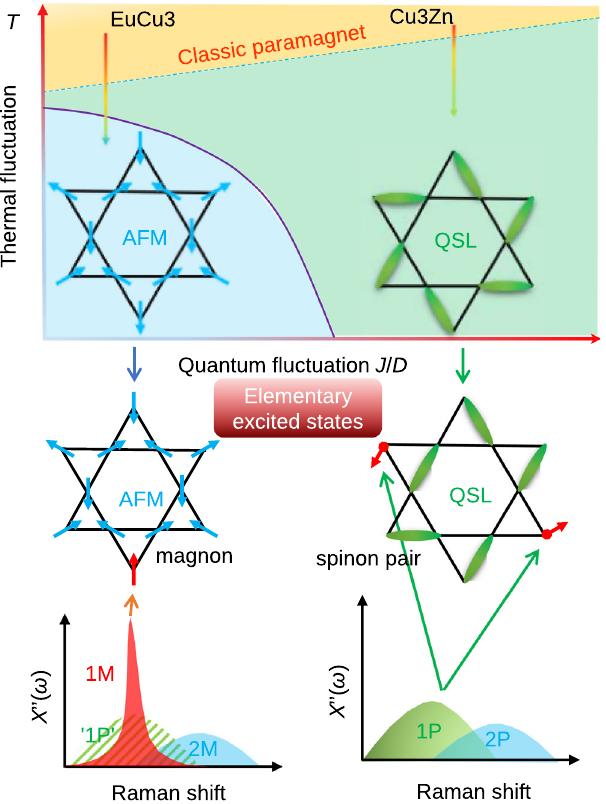
Fig. 1 Schematical comparative Raman responses for the AFM and QSL states. With a large DM interaction D , the kagome antiferromagnet develops a chiral 120° AFM ground state. Increasing J / D , the fl uctuation of the kagome system increases, driving the system into the QSL state. By increasing the temperature, the thermal fl uctuation melts the magnetic order and turns the system into the classic paramagnetic state at high temperatures. Cu 3 Zn and EuCu 3 have the QSL and AFM ground states, and allow spinon and magnon excitations, respectively. Magnetic Raman scattering measures different elementary excited states in the two different ground states. Here 1P and 2P denote the one-pair and two-pair spinon excitations, respectively. 1M and 2M in AFM ordered state denote the one- and two-magnon excitations, respectively. The 1M Raman peak in AFM measures the magnon while the 1P Raman continuum in QSL probes the spinon excitations. The shadow background of the 1M peak, marked as `1P', denotes the continuum above T N in EuCu 3 , mimicking the 1P continuum in the QSL